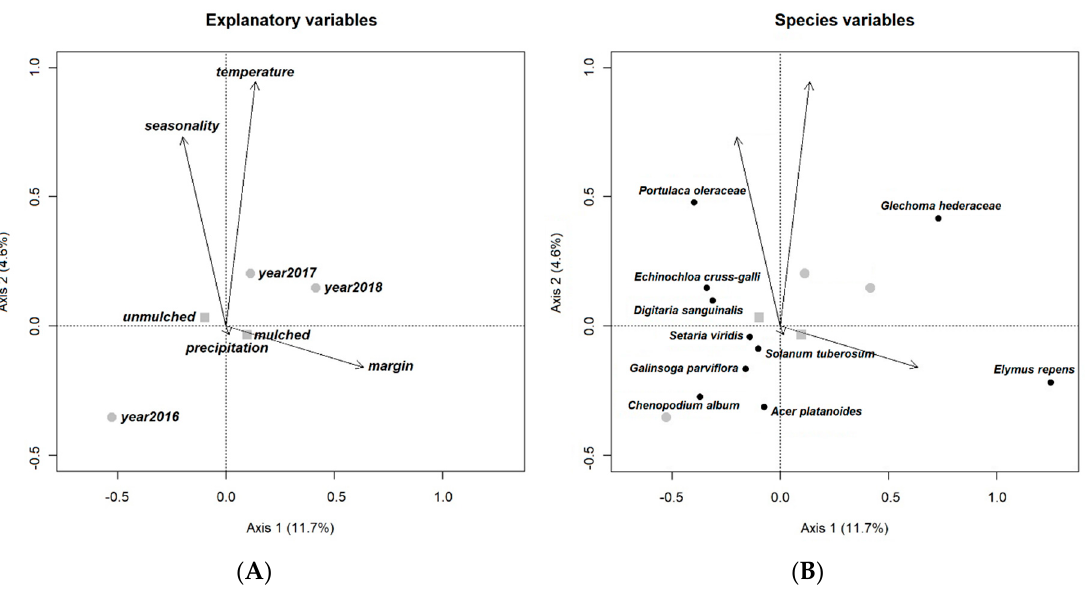
Table 5. Gross and net e ff ects of explanatory variables on weed seed bank in an open-field tomato experiment identified using redundancy analysis (RDA) with single explanatory variables (Gödöll˝o, Hungary,